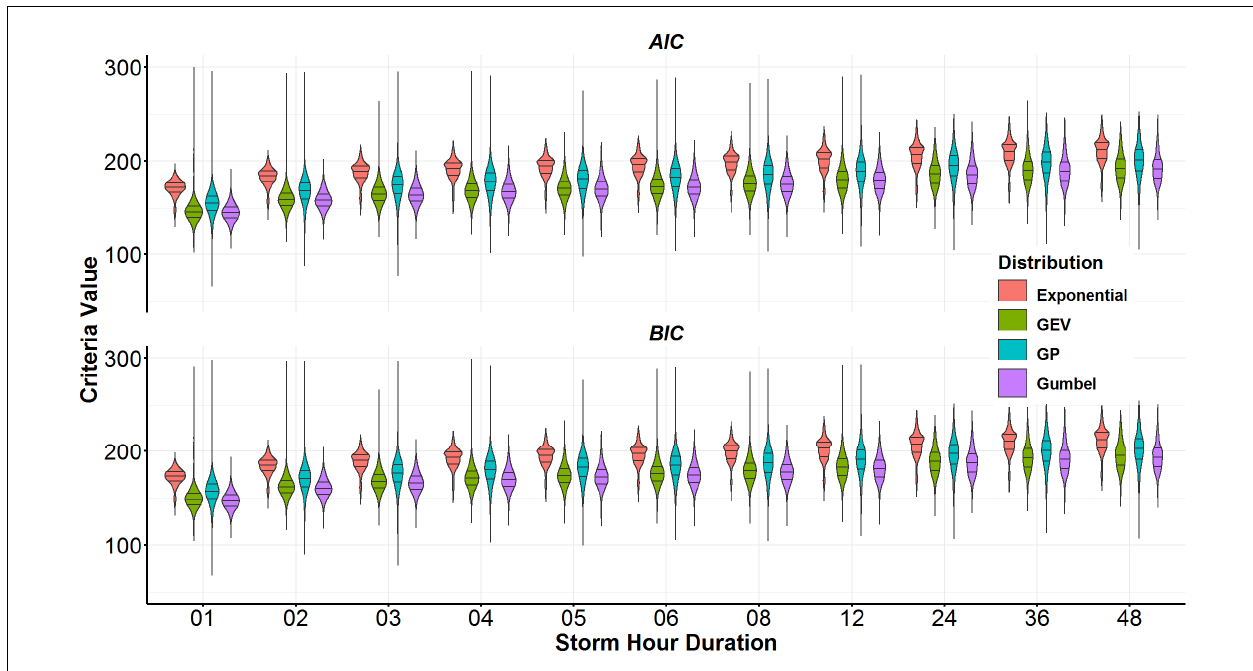
Figure 5. Violin plots showing the distribution of the AIC and BIC for each storm hour duration and each model (the three lines inside the violin represent the 25%, 50%, and 75% quartiles).